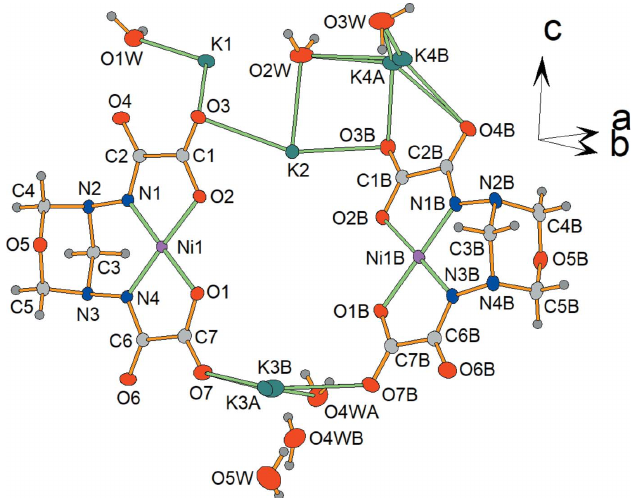
Figure 2 The asymmetric unit of ( 1 ) with displacement ellipsoids shown at the 50% probability level. The potassium cations K3 and K4 and the solvate water molecule O4 W are disordered over two positions, namely K3 A and K3 B , K4 A and K4 B , O4 WA and O4 WB , respectively.